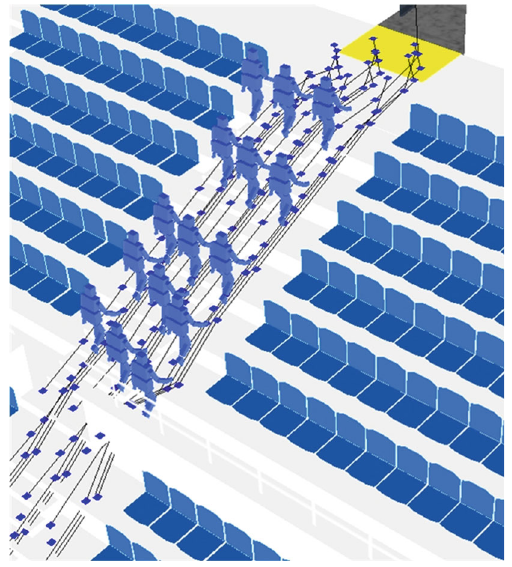
Figure 19: The editing result when characters move through the